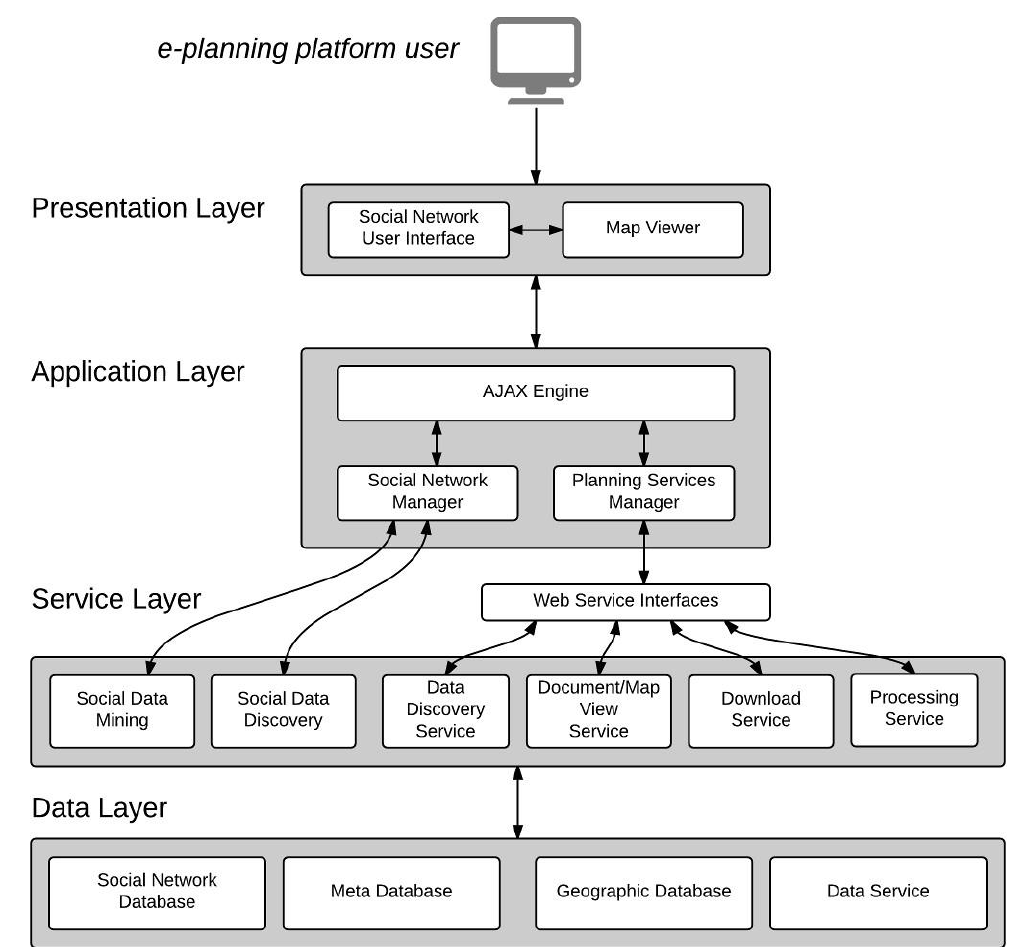
Figure 3. Conceptual four-tier architecture for an e -planning